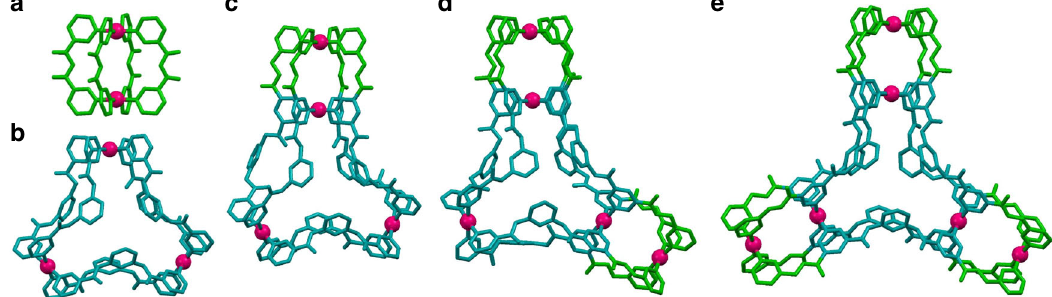
Fig. 5 Crystal structures showing the cationic portions. a Cage 2c (binuclear), b cage 3a (trinuclear), c cage 4acI (tetranuclear), d cage 5c (pentanuclear), and e cage 6c (hexanuclear) (encapsulated guests, counter-anions, solvents, and hydrogen atoms are excluded for clarity. ORTEP diagram for complexes and suitable crystal structures showing encapsulated guests are available in the Supplementary Figs. 134 –